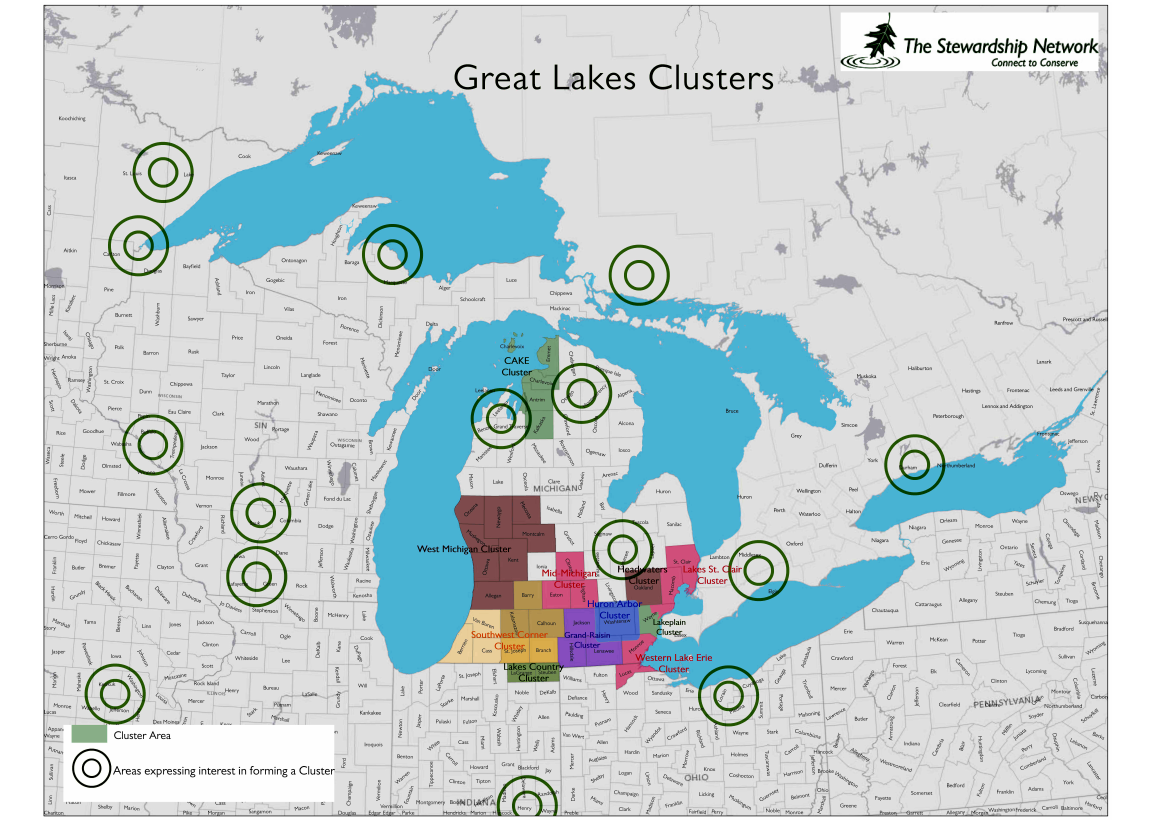
Fig. 1. The Stewardship Network’s current clusters (colored polygons) and emerging clusters (circles) in the Great Lakes